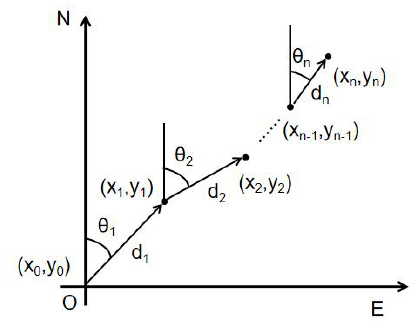
Figure 1 . Basic model of PDR